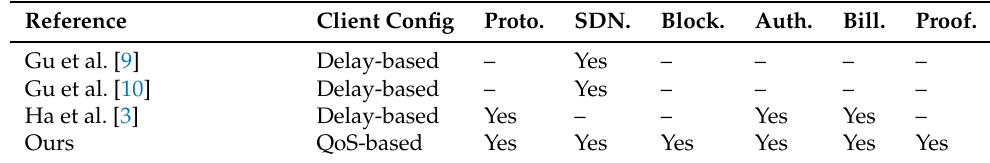
Table 4. Feature comparisons with existing RTP works.